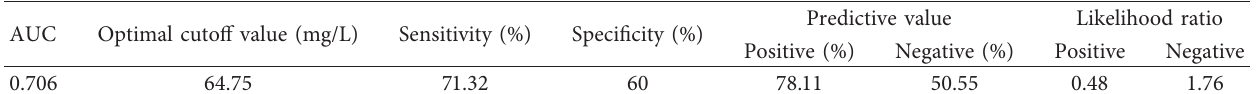
Table 3: The area under the ROC curve (AUC) and the optimal cutoff value of CRP.